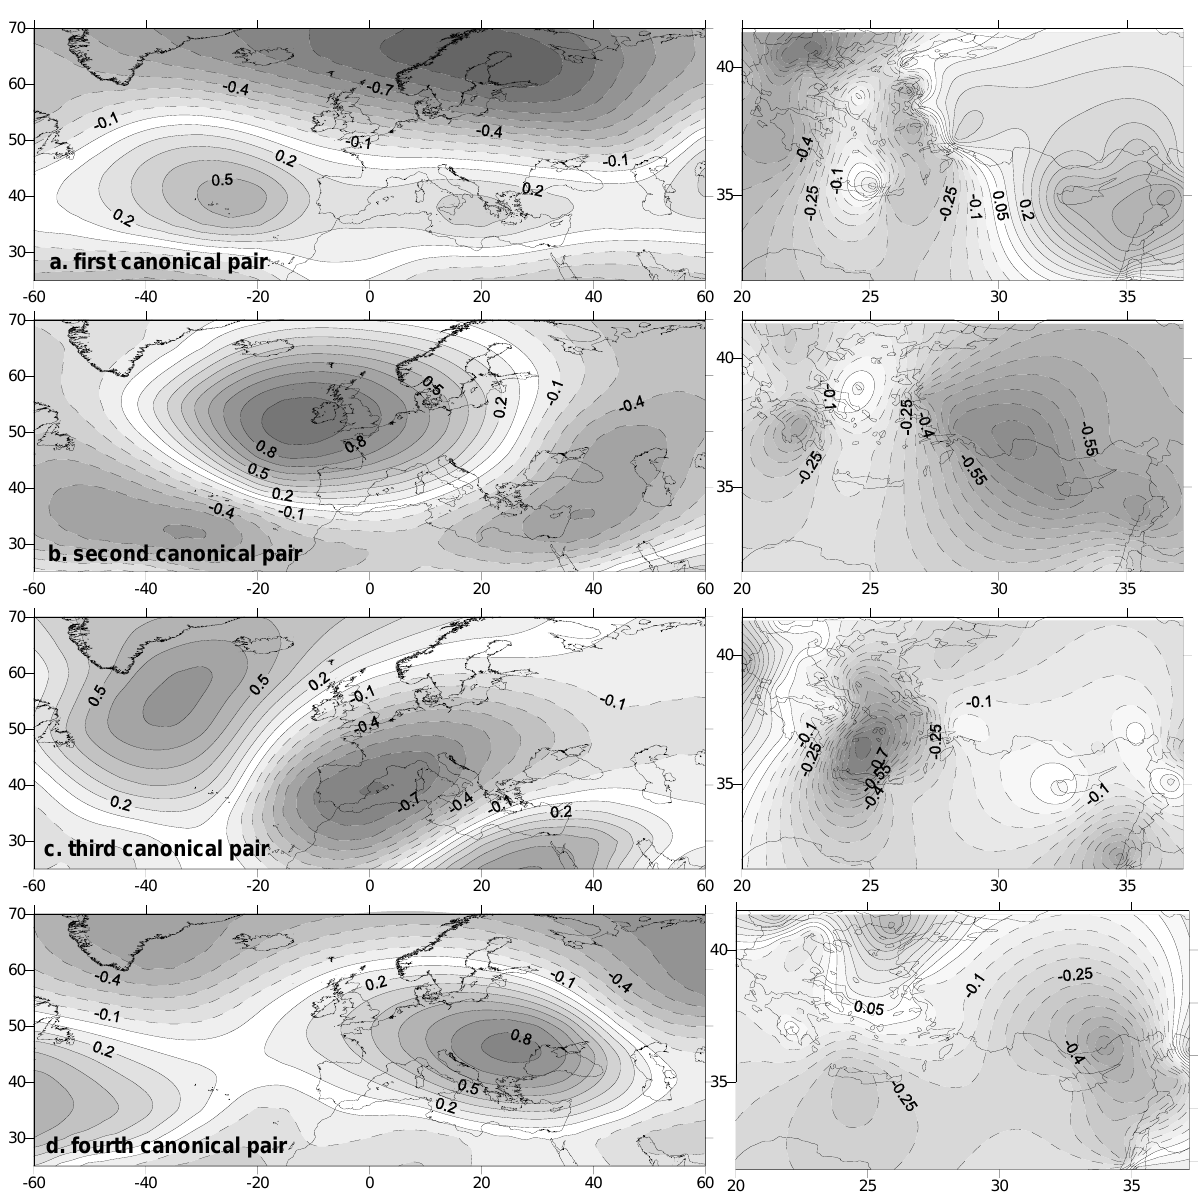
Fig. 2. Canonical correlation loadings of four RCCA pairs – (a) , (b) , (c) and (d) , respectively – for the 500hPa geopotential heights (left column) and SDII (right column) for the future climate (B2a scenario); dashed contours indicate negative values. but shifted eastwards, as found by Hatzaki et al. (2006). The sign of its impact in EM climate is the same compared to the control run, but with larger loadings suggesting a domi- nant role of the pattern during winter in the future (Fig.